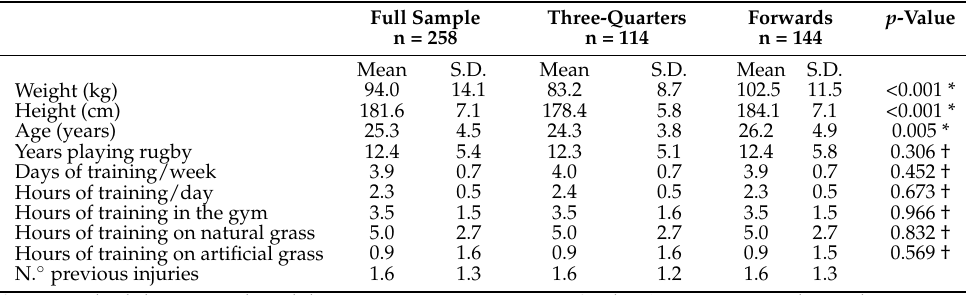
Table 1. Anthropometric data and sports habits injury